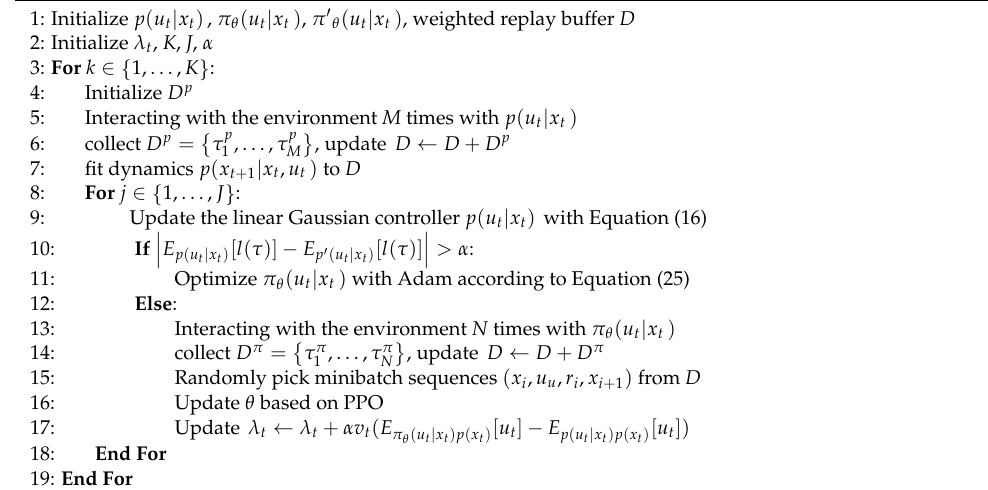
Algorithm 1. WNEPO: A two-phase framework for efficient robotic skills